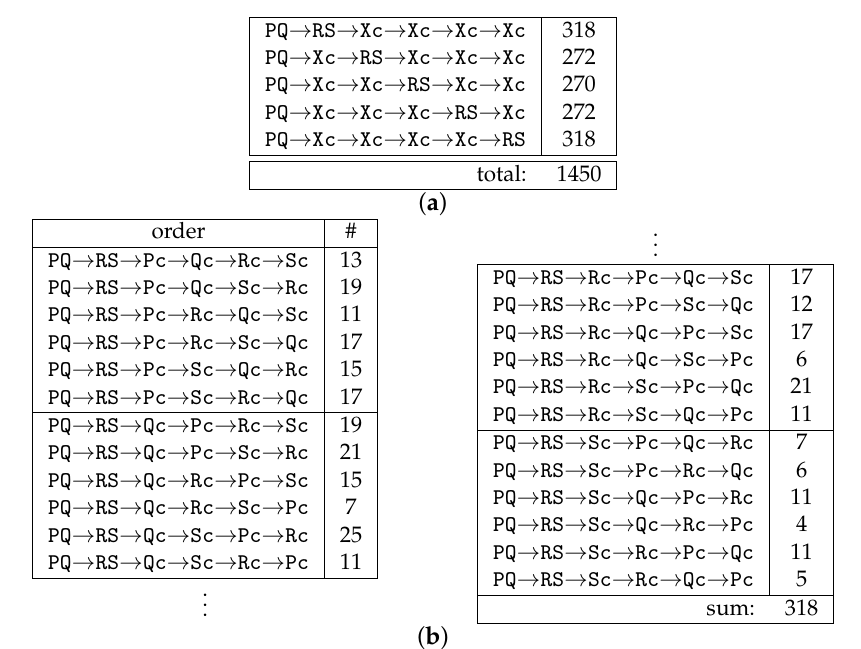
Table 8. Possible orders of points in 6-opt operations and number of different possible permutations: ( a ) general overview; ( b ) specific cases of PQ → RS → Xc → Xc → Xc → Xc